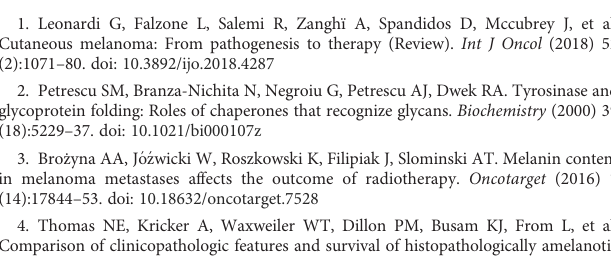
SUPPLEMENTARY FIGURE 1 LC-MS/MS proteome comparison of melanoma cells grouped according to their phenotype (A) Volcano plot showing the log2FC vs -log10(q value) from two sample t test of amelanotic cells vs highly pigmented MNT1 cell line. (B) Heatmap of log2 transformed LFQ intensity values showing the statistically signi fi cantup-regulated proteinsfromthecomparison betweenamelanotic cell lines and highly pigmented MNT1 cells. (C) Venn diagram depicting unique and shared set of upregulated proteins in amelanotic cells vs MNT1 cells in both comparisons (normoxia and hypoxia). (D) Heatmap of signi fi cantly upregulated proteins in amelanotic cells compared to highly-pigmented MNT1 cells in hypoxia (q value<0.05 and log2FC ≥